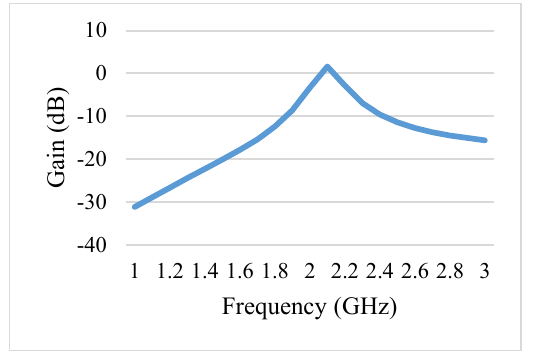
Fig.1.5 Gain vs Frequency relationship of Antenna 1